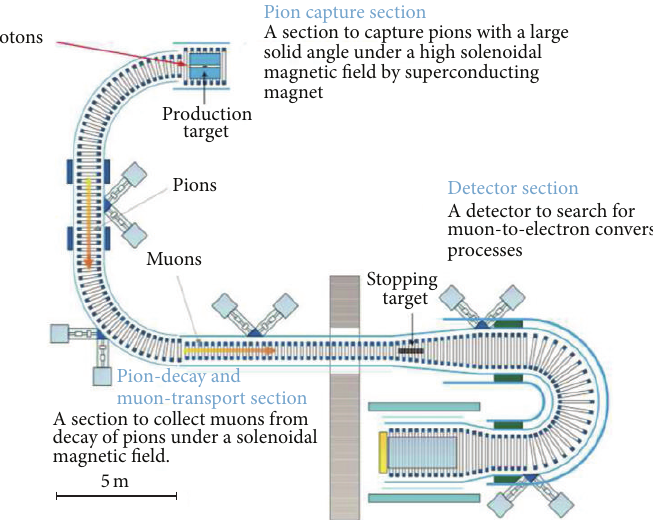
Figure 26: Layout of the COMET